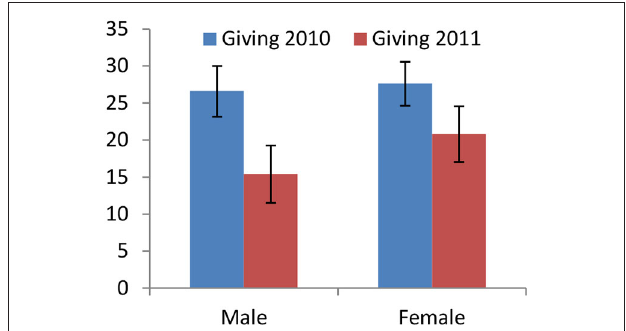
FIGURE 6 | Giving in the Dictator Game by the same subjects in 2010 and 1 year later (Brañas-Garza et al., 2013), disaggregated by gender . Even though both genders decrease significantly their giving, men adjust their behavior more than women.